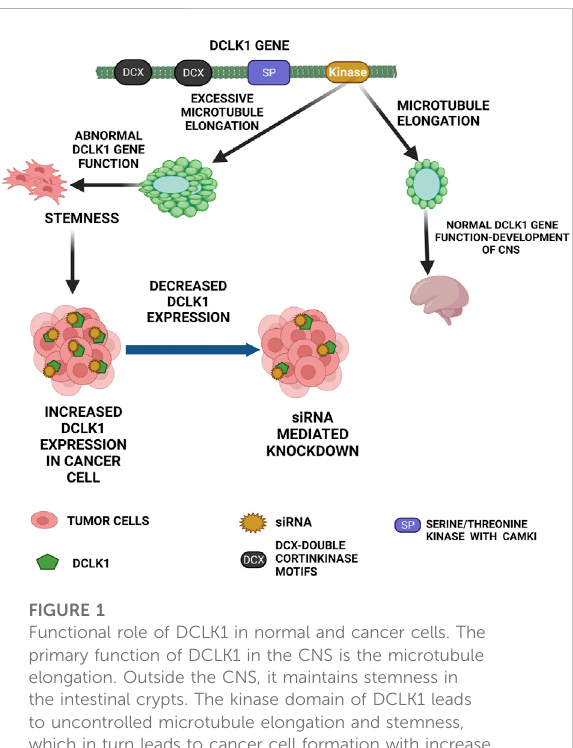
FIGURE 1 Functional role of DCLK1 in normal and cancer cells. The primary function of DCLK1 in the CNS is the microtubule elongation. Outside the CNS, it maintains stemness in the intestinal crypts. The kinase domain of DCLK1 leads to uncontrolled microtubule elongation and stemness, which in turn leads to cancer cell formation with increase in DCLK1 expression. As observed, DCLK1 upregulation in several malignancies can be downregulated by siRNA- mediated knockdowns and other related